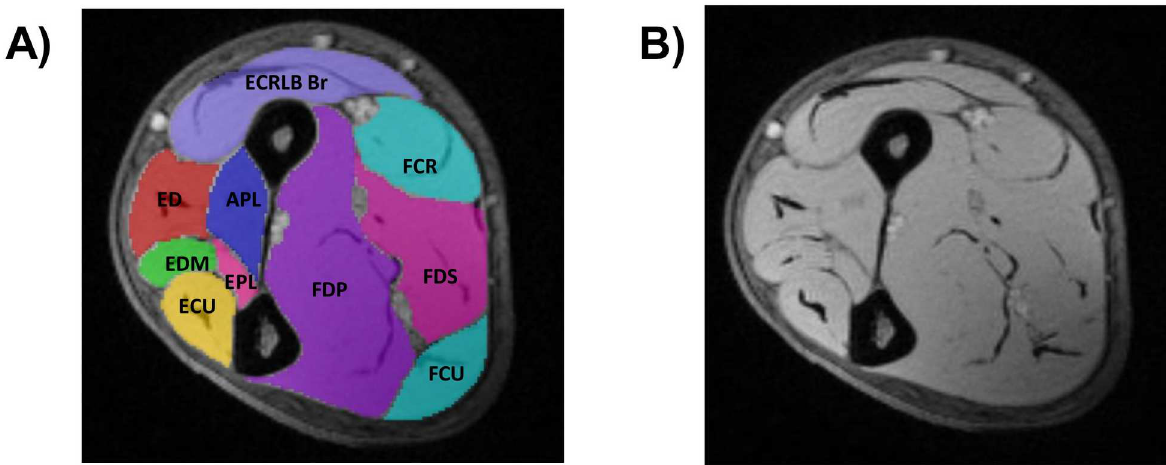
Fig 1. Muscle segmentation (A) and raw 3-point Dixon (B) of the central slice in the dominant forearm of a healthy control. DORSAL compartment : Extensor carpi ulnaris (ECU), extensor digiti minimi (EDM), extensor digitorum (ED), extensor pollicis longus (EPL), abductor pollicis longus (APL), extensor carpi radialislongus/brevis and brachioradialis (ECRLB Br). VOLAR compartment : flexor digitorum profundus and flexor pollicis longus (FDP), flexor digitorum superficialis and palmaris longus(FDS), flexor carpi ulnaris (FCU), flexor carpi